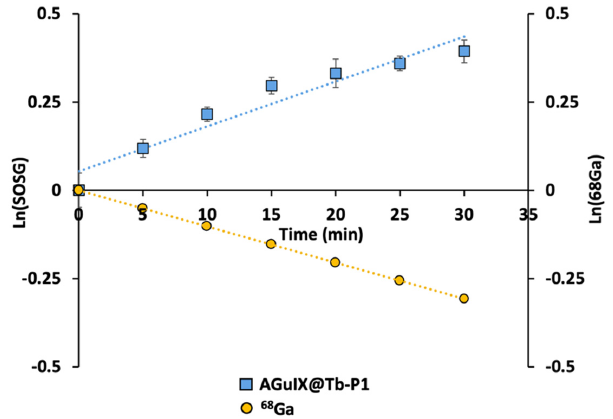
Figure 2. Slope comparison of singlet oxygen production dynamic and Gallium-68 decay. The Gallium-68 ( 68 Ga) decay presented here was determined numerically by applying the exponential decay law whereas singlet oxygen production was assessed by SOSG fluorescence measurements.